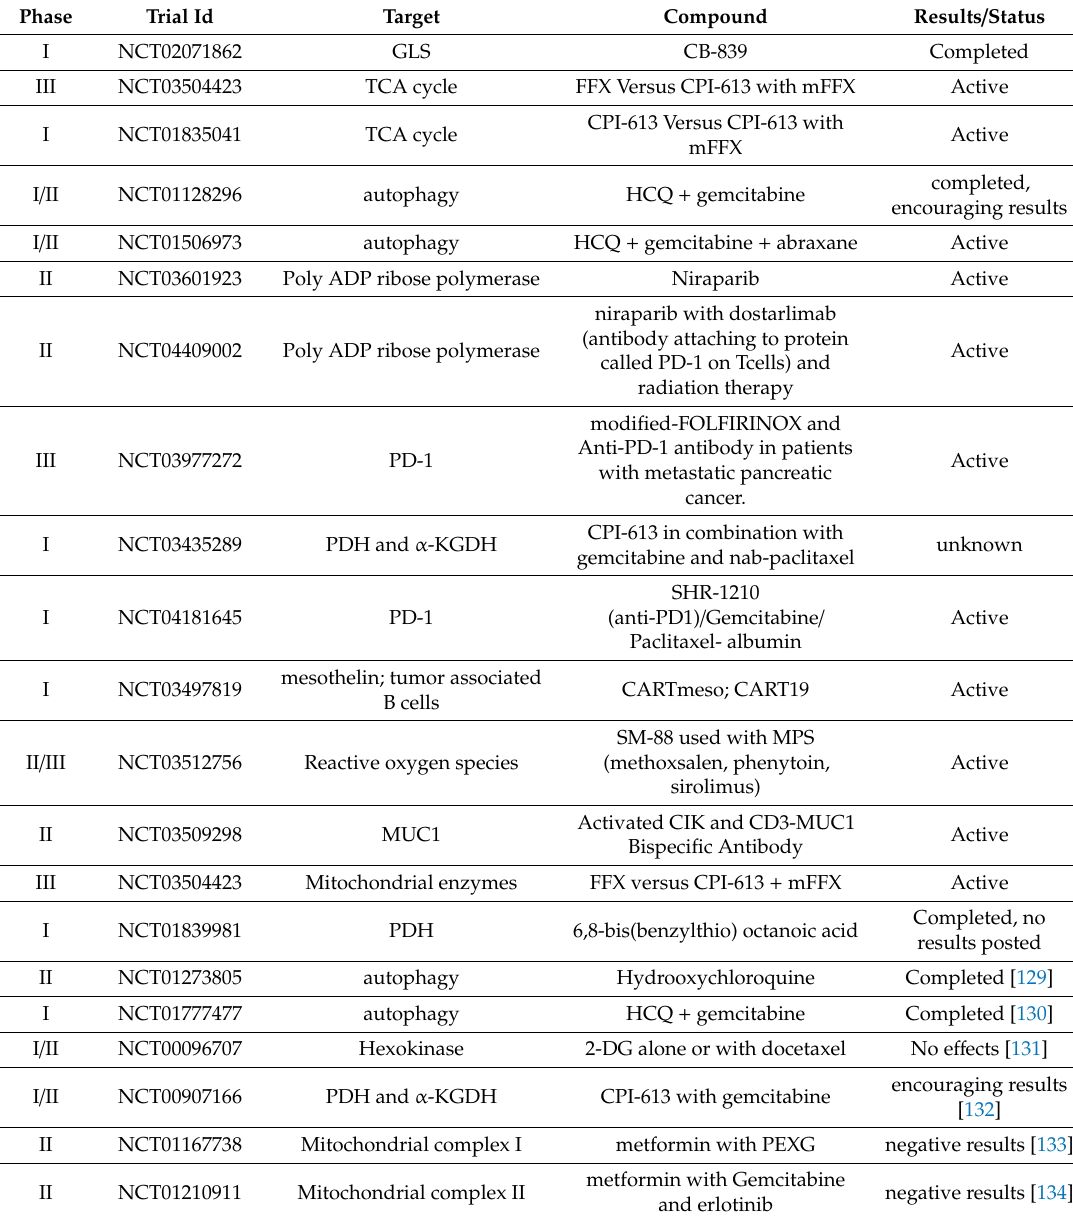
Table 1. Clinical trials targeting metabolomic enzymes in pancreatic